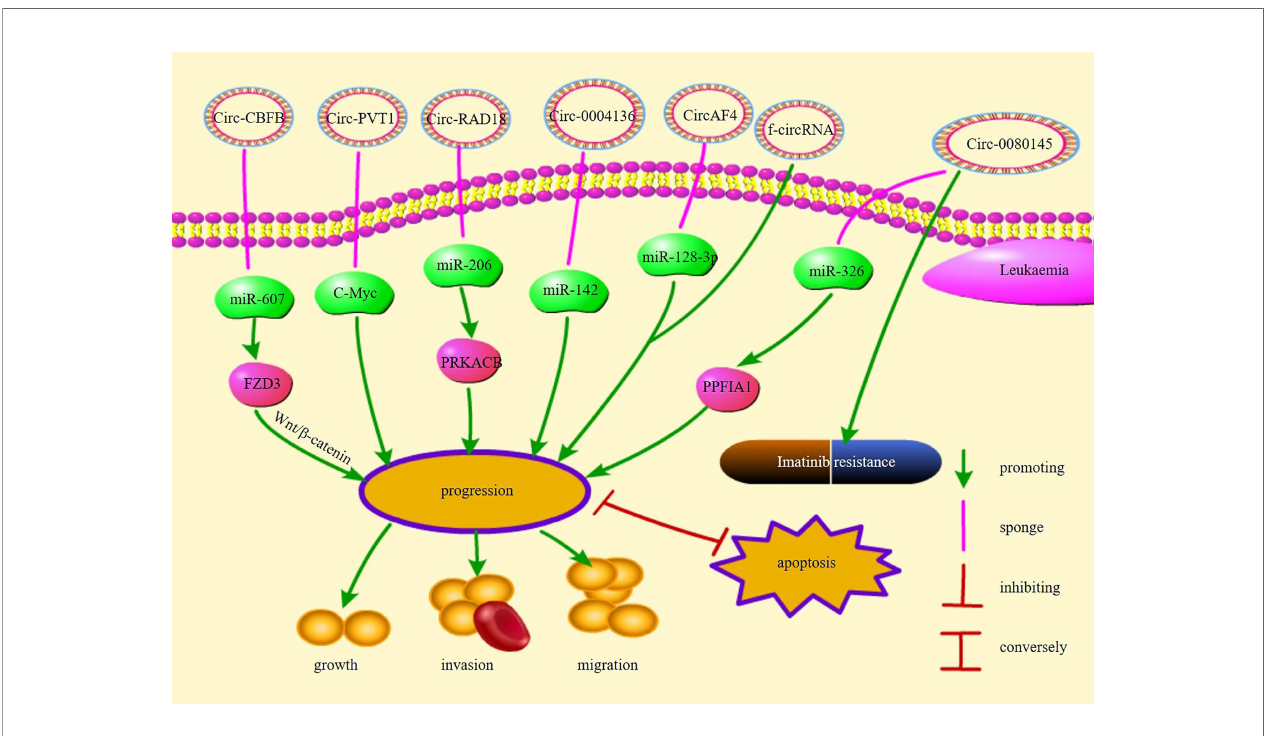
FIGURE 1 | The regulatory mechanisms and their functions of circRNAs in leukemia.